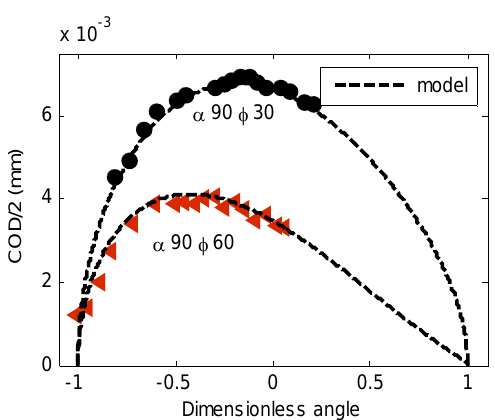
Figure 10: t = 5mm; crack length 2  (  0°) and ( 